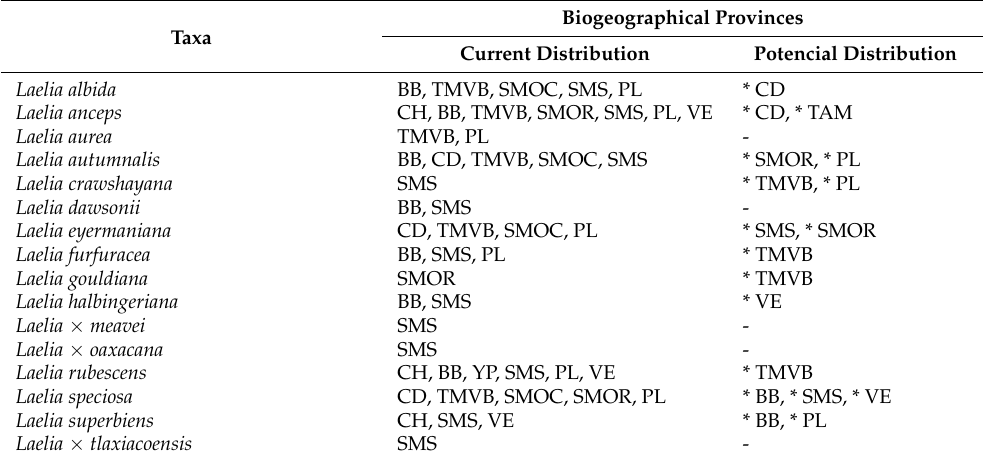
Table 3. Current and potential distribution of Laelia s.l. by biogeographical provinces.